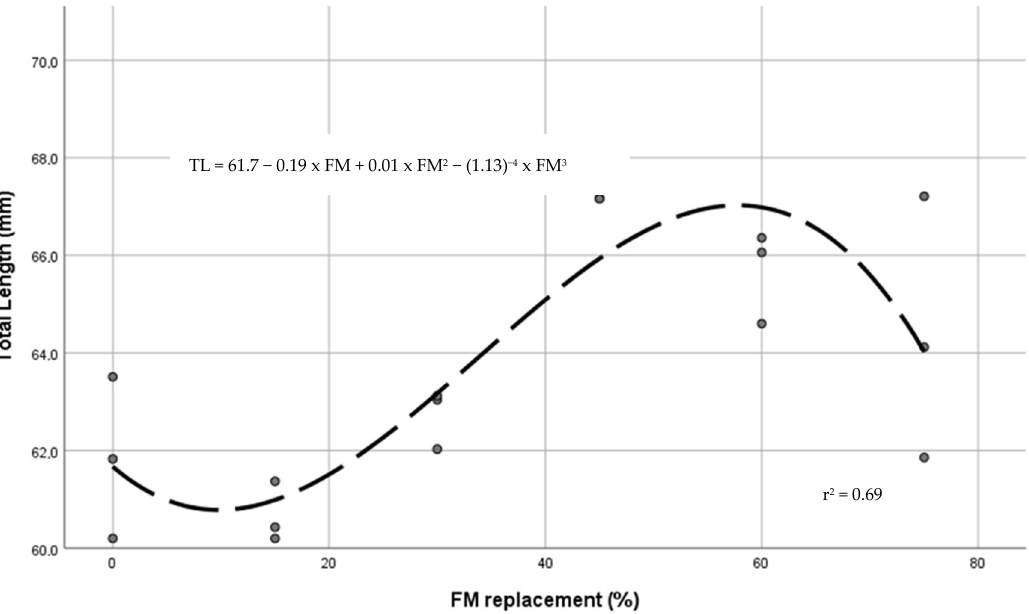
Figure 1. Regression curve between dietary BSFLM and juvenile tench total length (TL). The condition factor (K) ranged from 1.27 to 1.38, being significantly higher in tench fed the control diet. Regarding FCR, the lower value (1.08) corresponds to fish fed with the 45% FM substitution. The percentages of fish with externally visible deformities was low, ranging from 0% to 0.04%. Body deformities affected the spinal column and caudal peduncle (break in the tail